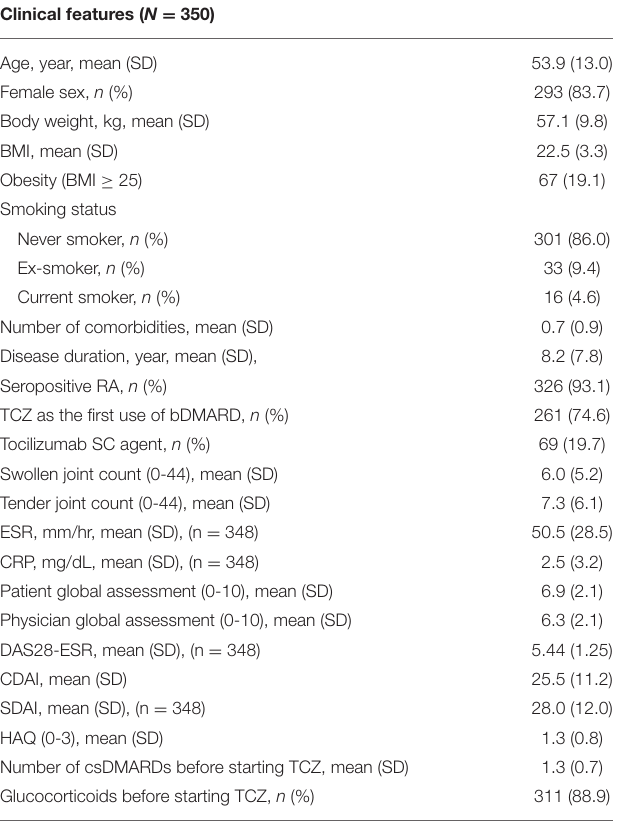
TABLE 1 | Baseline characteristics of the patients. Clinical features ( N =